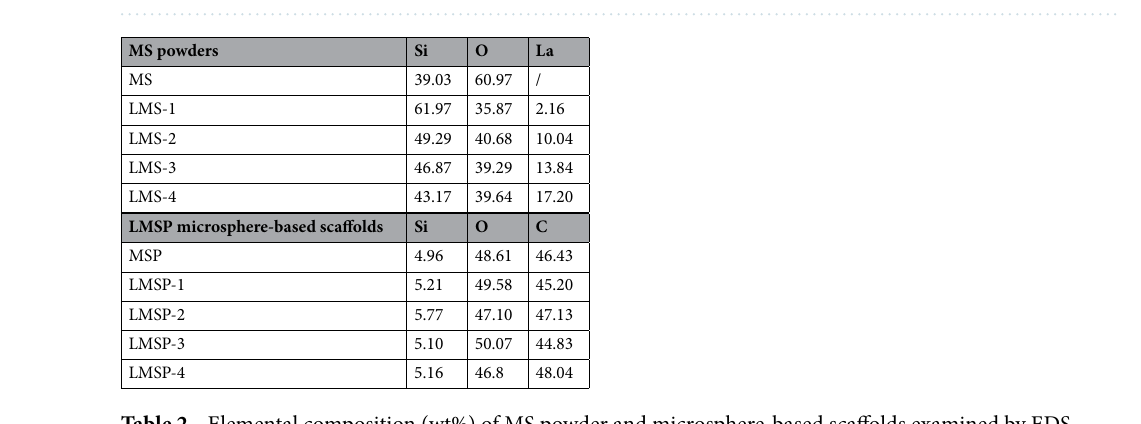
Table 2. Elemental composition (wt%) of MS powder and microsphere-based scaffolds examined by EDS.